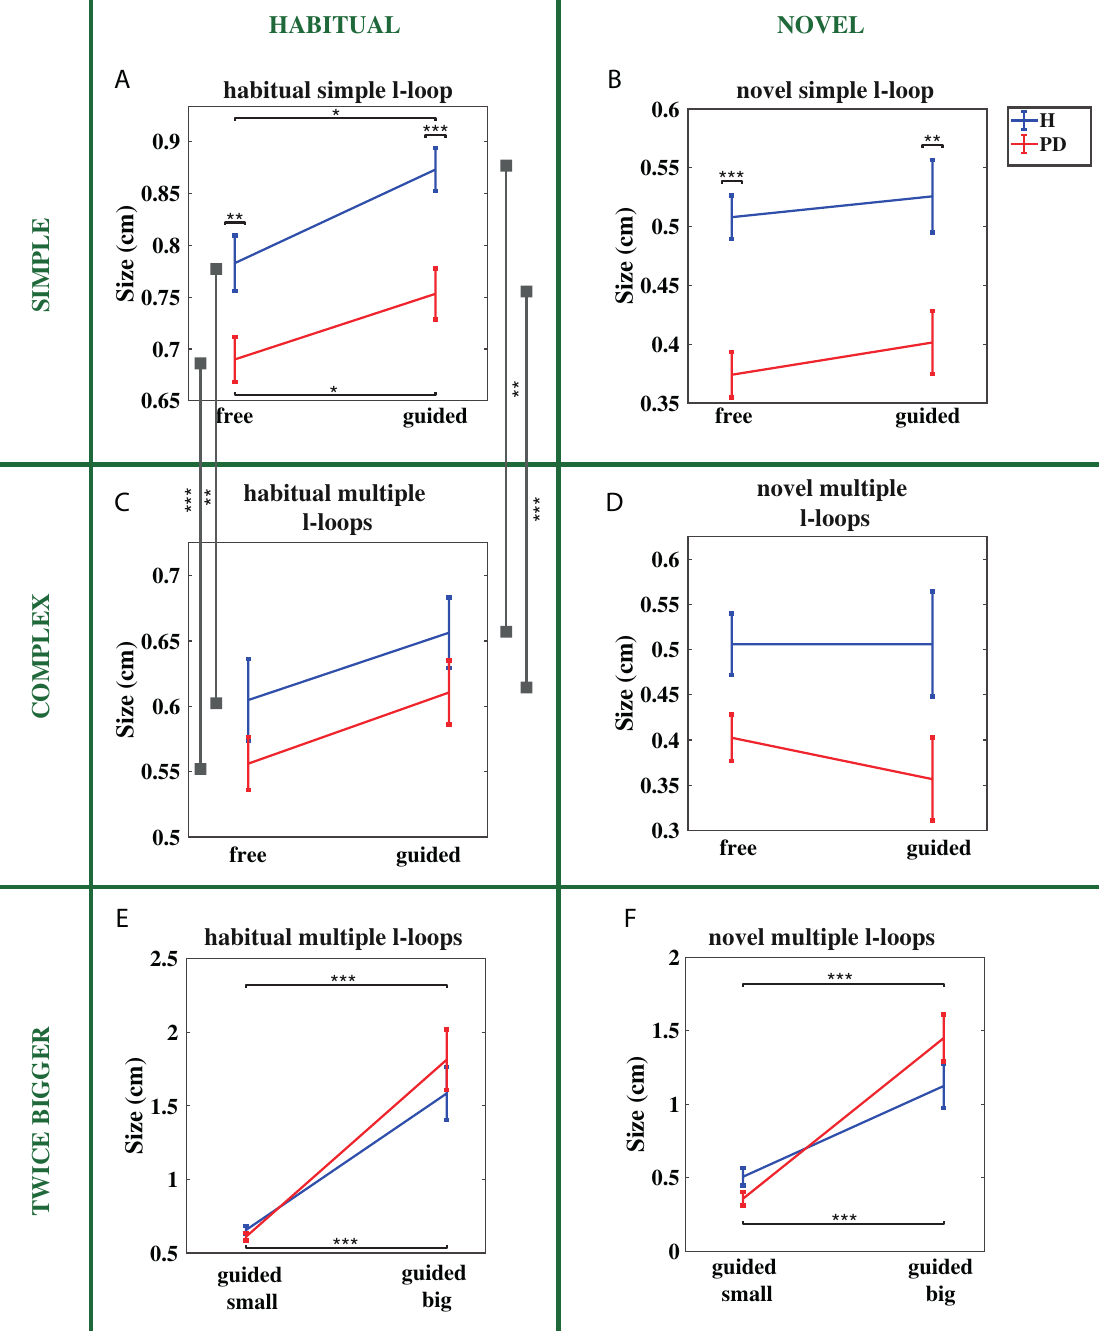
Figure 7. Stroke size (mean ± SEM) across PD patients (red lines) and H subjects (blue lines) for all conditions: ( A ) Habitual simple l-loop, ( B ) Novel simple l-loop, ( C ) Habitual multiple l-loops, ( D ) Novel multiple l-loops, ( E ) Habitual multiple l-loops, ( F ) Novel multiple l-loops. Grey and black lines indicate the results of t -tests that gave significant differences. Stars indicate the results of one-tailed t -tests corrected with the FDR procedure (* p < 0.05; ** p < 0.01; *** p <